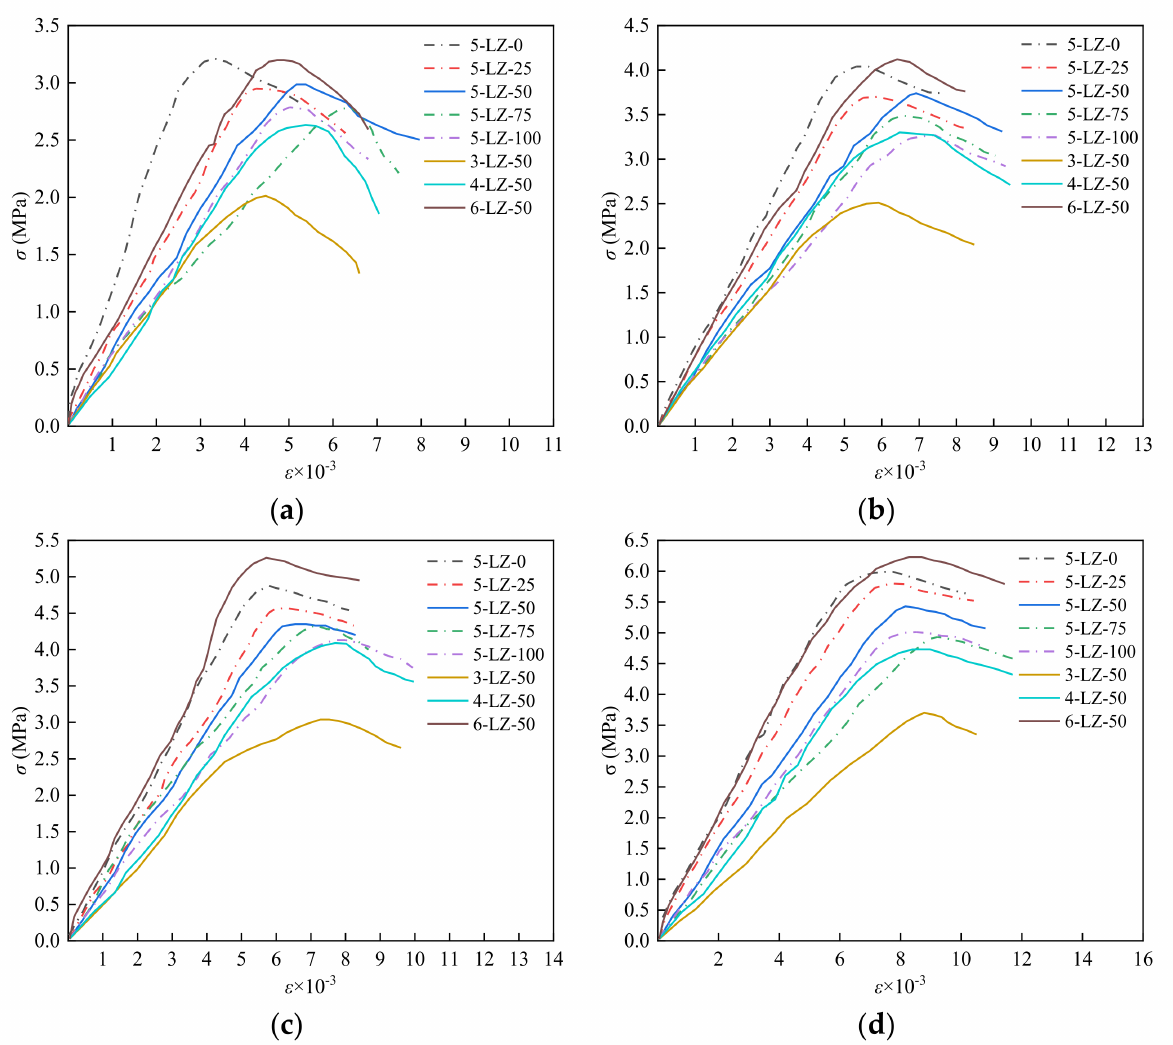
Figure 10. Stress–strain curves of the specimens: ( a ) σ 2 = σ 3 = 0, ( b ) σ 2 = σ 3 = 0.5 MPa, ( c ) σ 2 = σ 3 = 1 MPa, and ( d ) σ 2 = σ 3 = 1.5